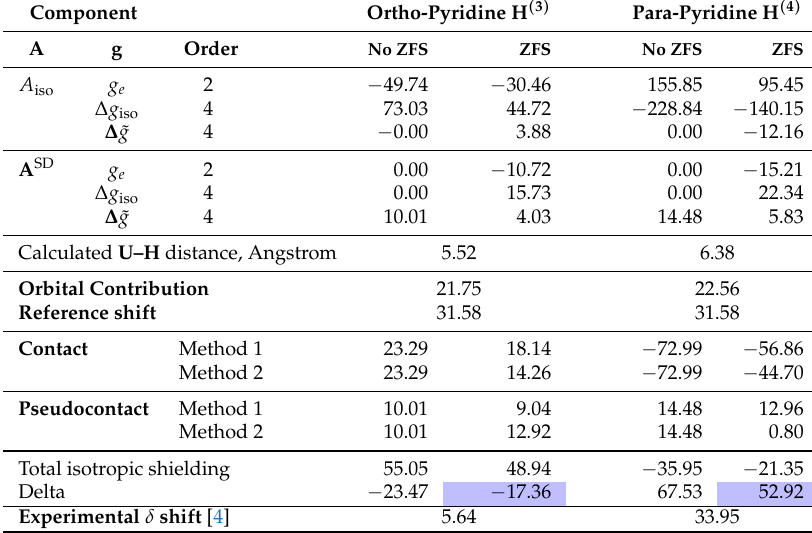
Table 7. Calculated 1 H pNMR shifts for the ring H atoms of U(MeBTP) 3 in ppm at 303 K. For numbering see Figure 5. The final, ZFS corrected, computational values are highlighted.